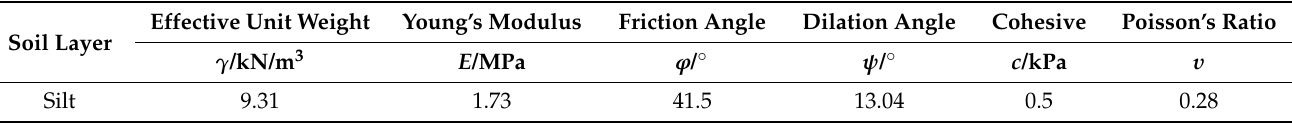
Table 3. Calculation parameters for the silt.